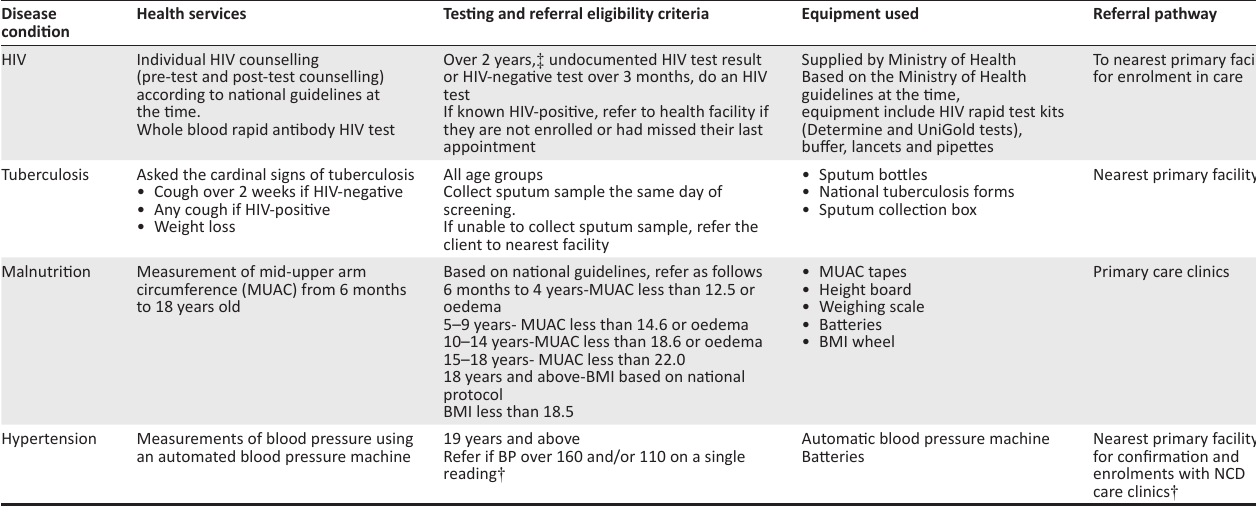
TABLE 1: Screening and referral criteria for home-based